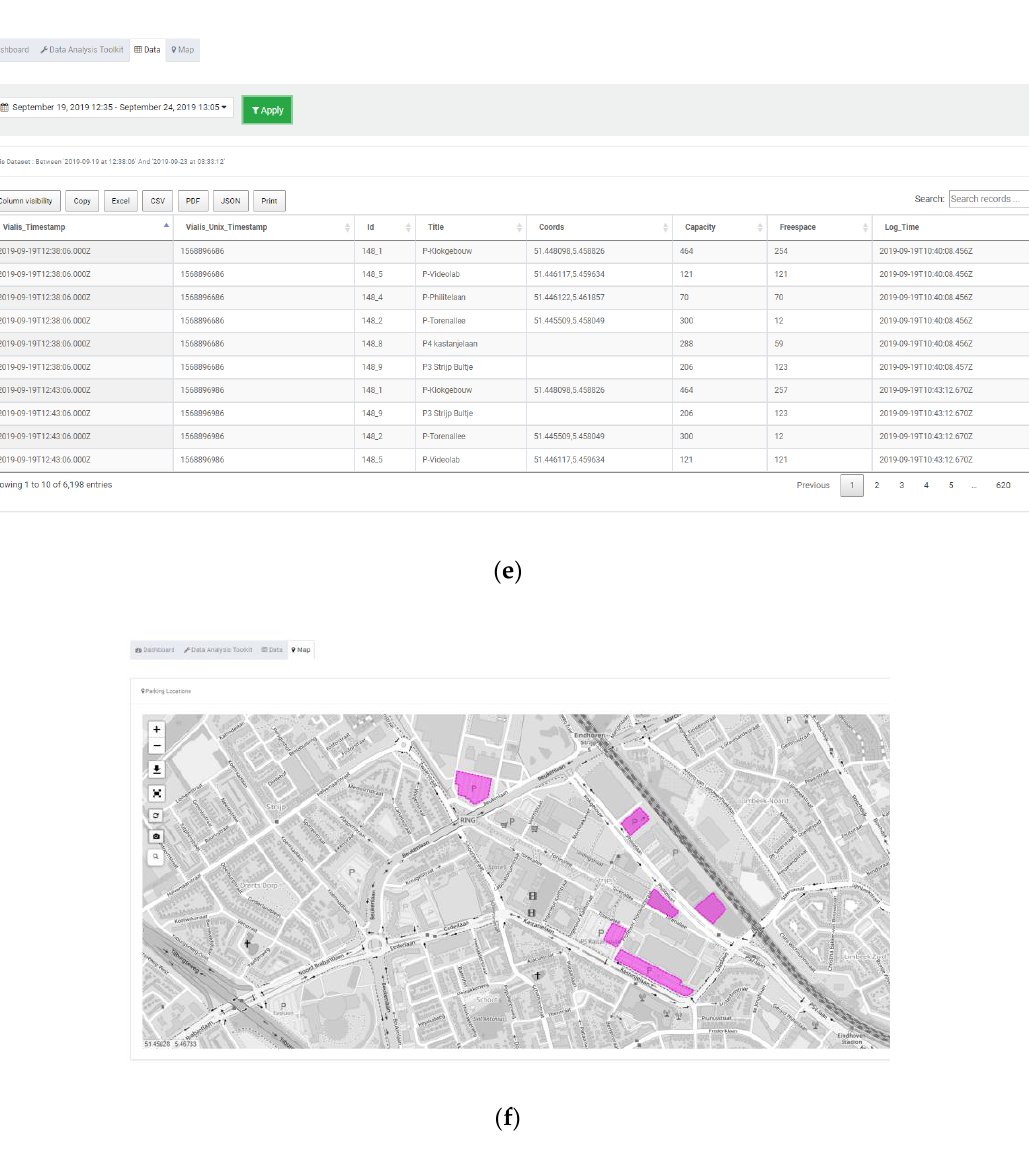
Figure 5. Sample screenshots of the Triangulum City Dashboard. ( a ) The main page, drill-down layout with menu, ( b ) Parking management dashboard, ( c ) Energy consumption management dashboard, ( d ) Data analytic toolkit, ( e ) Tabular data presentation, ( f ) Integrated maps.